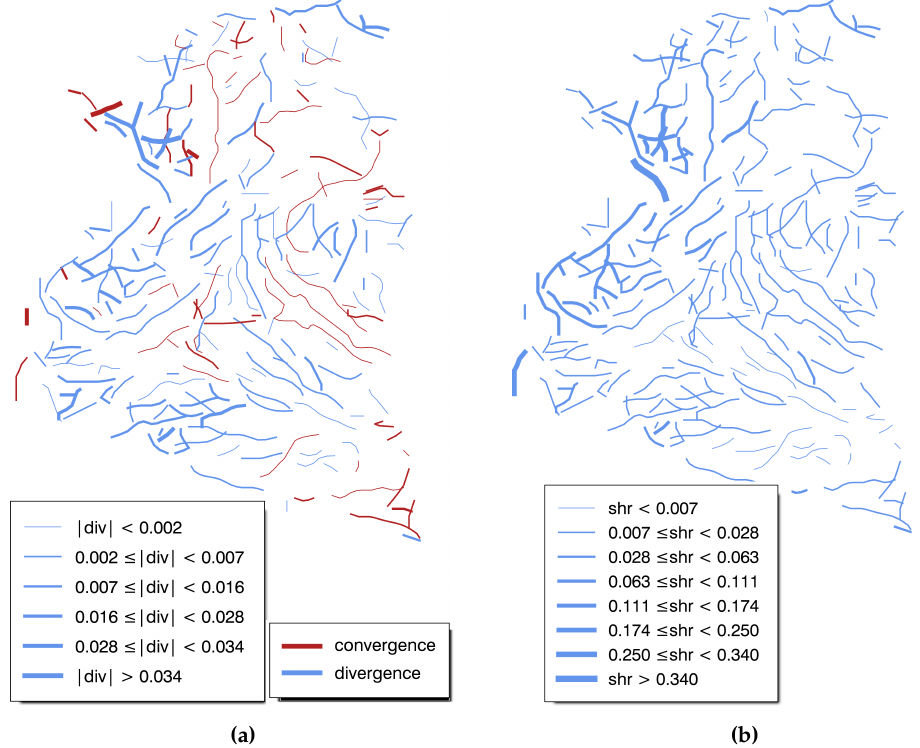
Figure 14. Subsets/mapping of gridded image data. ( a ) Divergence (1/day); ( b ) Shear (1/day).